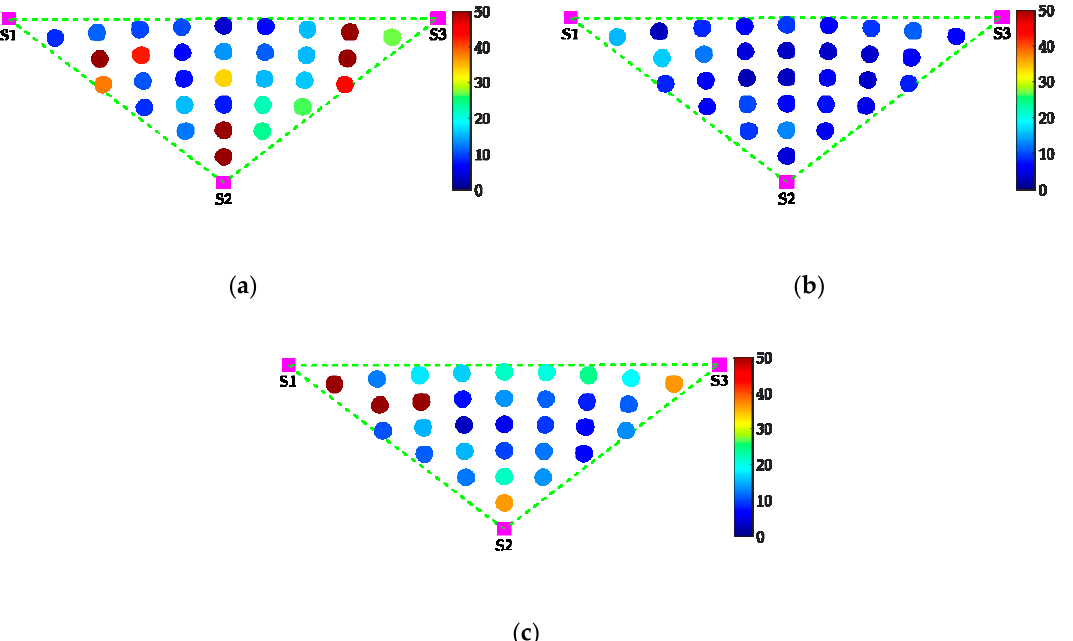
Figure 15. The distributions of absolute errors using the signals with different frequency bands ( a ) 0–100 kHz; ( b ) 100–200 kHz; ( c ) 200–300 filtering: ( a ) 0–100 kHz; ( b ) 100–200 kHz; ( c ) 200–300 kHz.